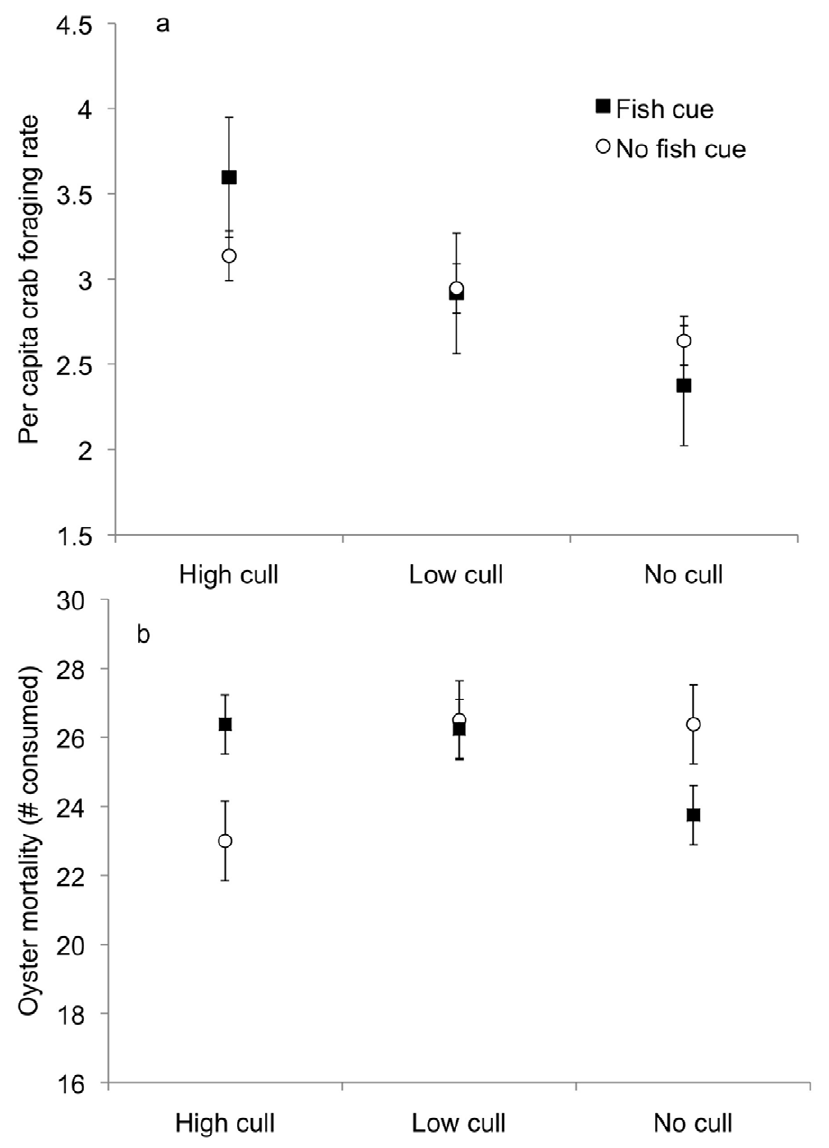
Figure 1. The effects of predator cue and mud crab removal rate on (a) mud crab per capita foraging rate and (b) the number of juvenile oysters consumed during Experiment I. There was no effect of predator cue on per capita mud crab foraging rates, but we show the predator cue treatments separately for comparison with panel b. Closed squares indicate catfish cue is present at high tide; open circles indicate catfish cue is absent at high tide. Symbols represent means( 6